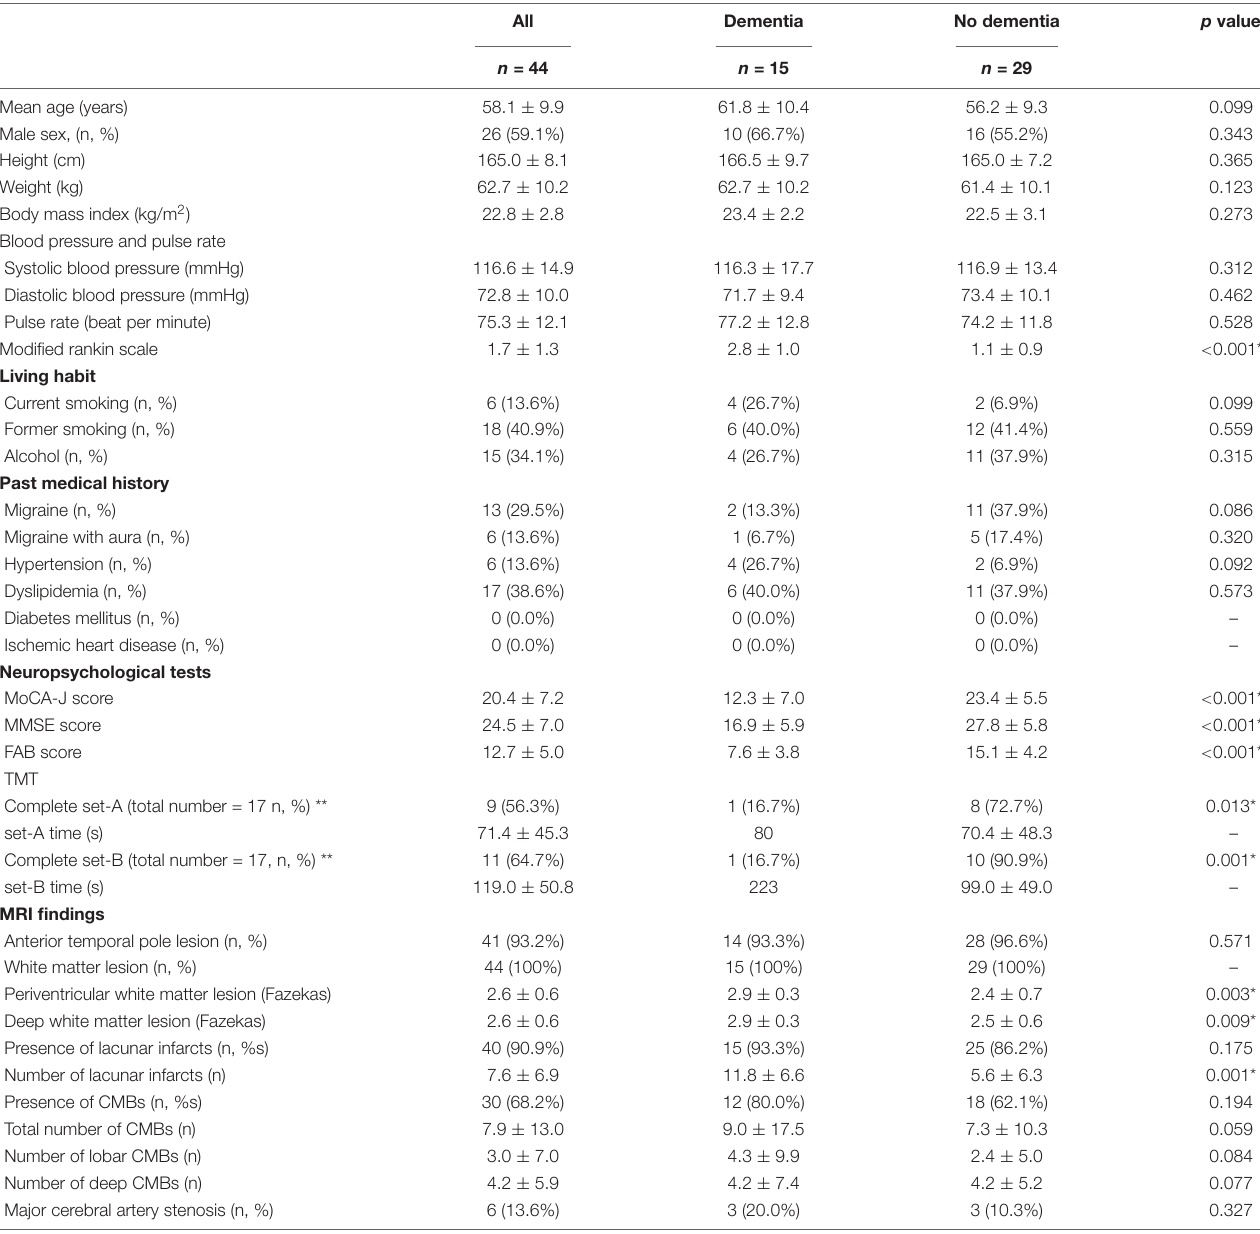
TABLE 1 | Characteristics in the 44 CADASIL patients.